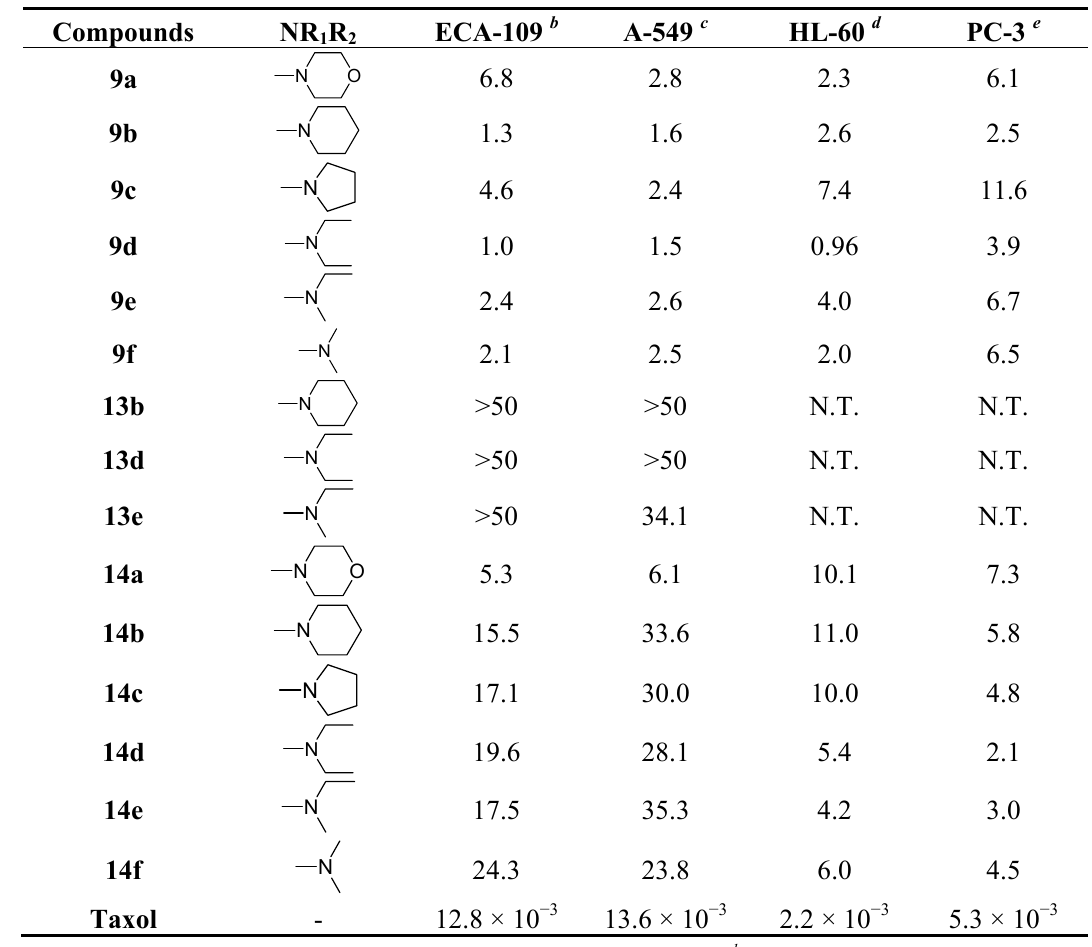
Table 1. In vitro cytotoxic activity of compounds 9a – f , 13b , 13d , 13e and 14a – f a , (IC 50